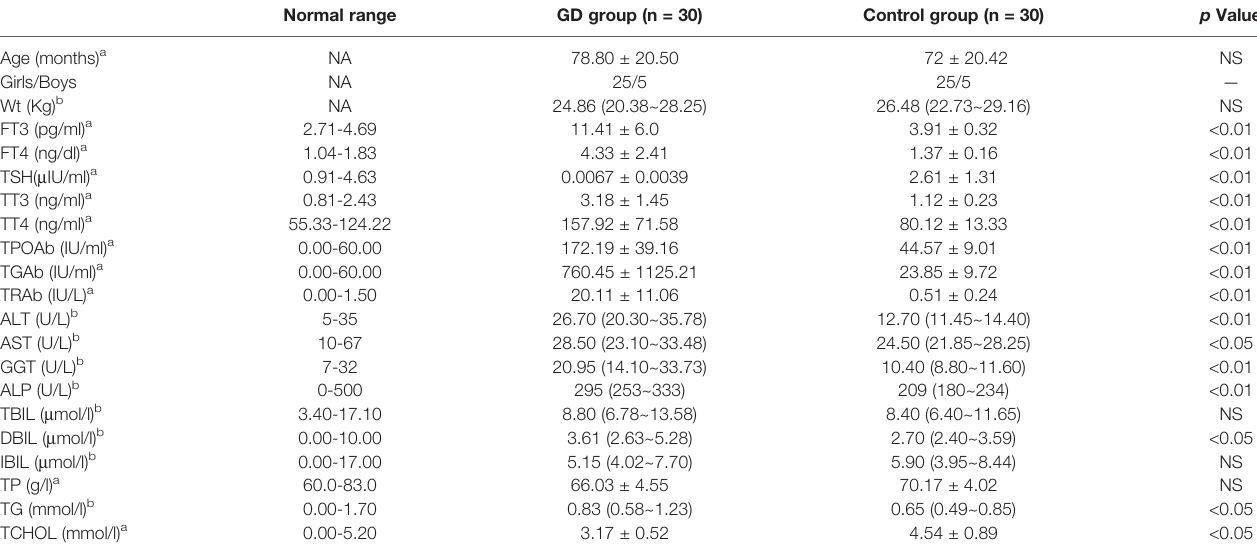
TABLE 1 | Clinical and biochemical characteristics of the GD and control